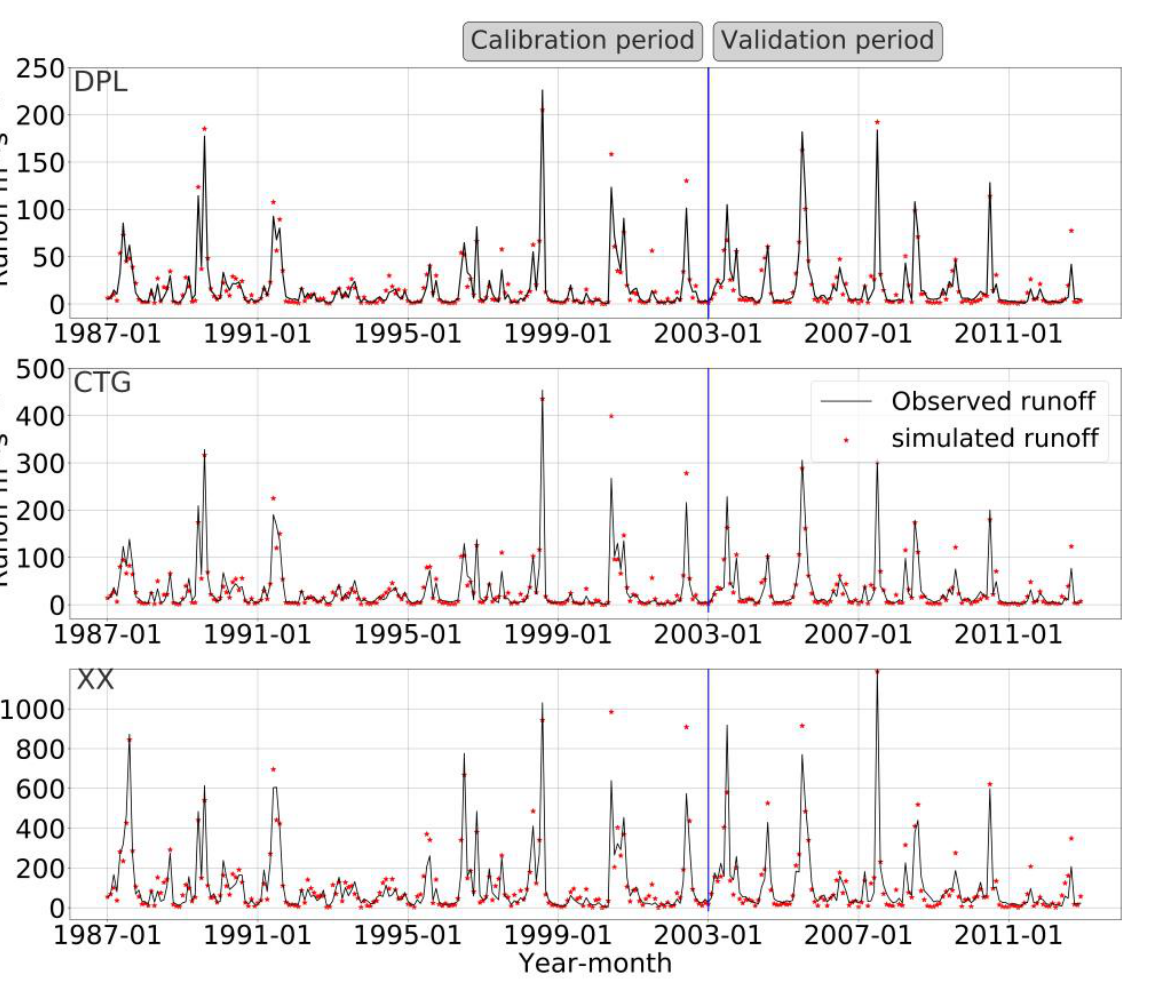
Figure 4. Comparison between the measured and simulated runoff values for the SWAT model in the DPL, CTG, and XX stations.